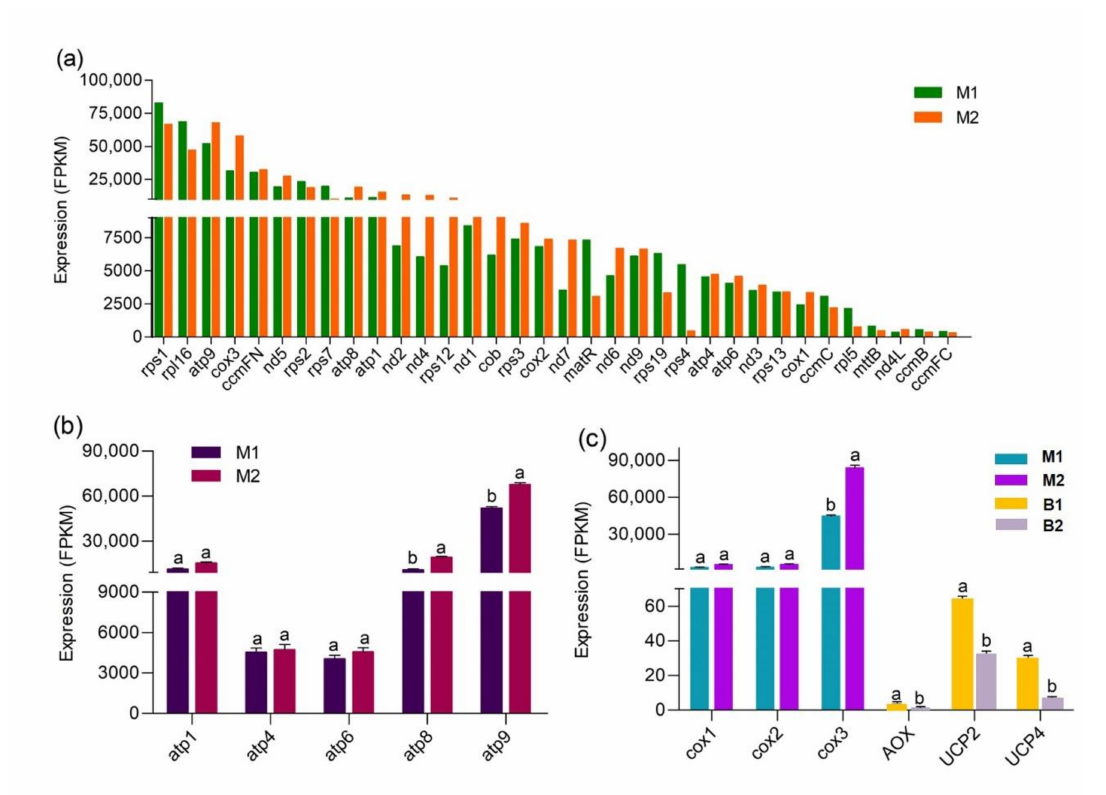
Figure 3. Differential expression analysis. ( a ) Quantification level of mitochondrial-protein-coding genes. ( b ) Expression level of mitochondrial ATP synthase genes at different stages. ( c ) Comparative analysis of expression level of key genes in different mitochondrial energy-metabolism